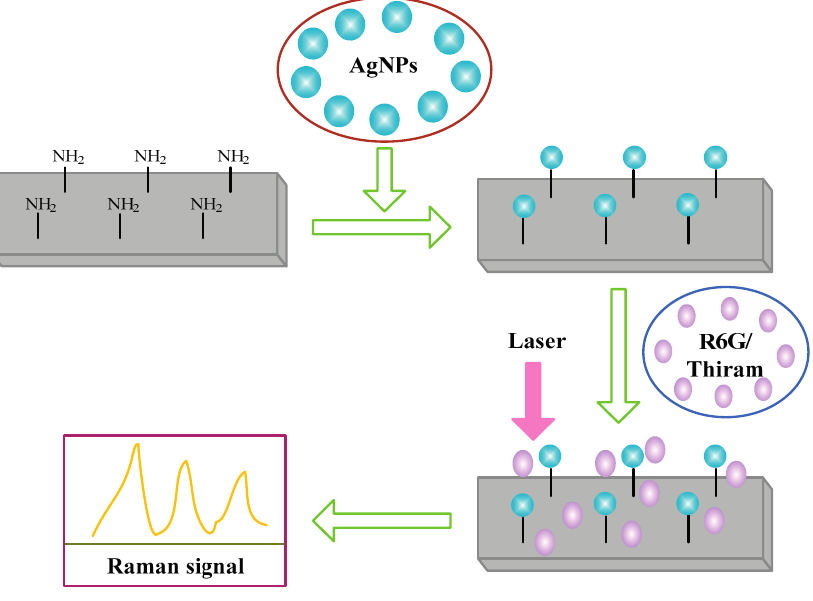
Figure 1. A schematic illustration of the fabrication process of the hybrid substrate and its application in surface-enhanced Raman scattering